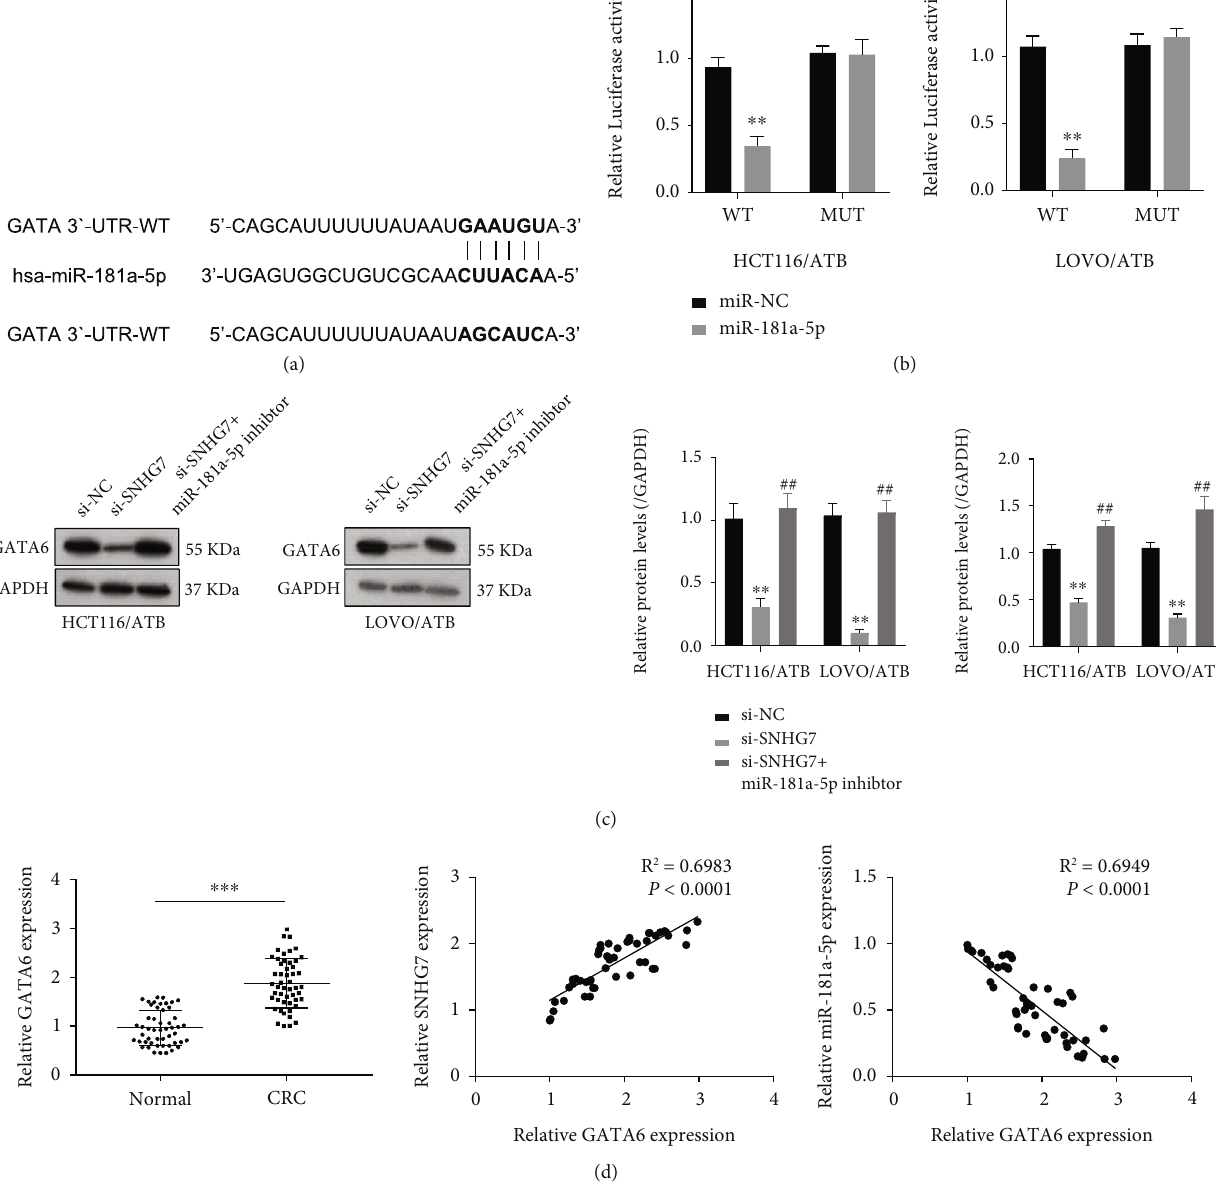
Figure 4: SNHG7 promotes GATA6 expression via sponging miR-181a-5p. (a) Potential binding site of miR-181a-5p in GATA6 found by TargetScan. (b) Luciferase reporter assay to verify the interaction between miR-181a-5p and GATA6 in HCT116/ATB and LOVO/ATB cell lines. miR-181a-5p overexpression inhibited Luciferase activity, but the inhibition disappeared when the binding site was mutated in GATA6. (c) Western blot and qRT-PCR showing the downregulation of GATA6 by SNHG7 knockdown and the upregulation of GATA6 by the transfection of miR-181a-5p in HCT116/ATB and LOVO/ATB cell lines. (d) qRT-PCR measurement to check the expression level of GATA6 in 50 pairs of CRCs and the adjacent tissues. A signi fi cant negative correlation between GATA6 and miR- 181a-5p and a signi fi cant positive correlation between GATA6 and SNHG7 were observed by Spearman correlation analysis in 50 cases of CRC. The statistical di ff erences were evaluated by Student ’ s t -test (* P < 0 : 05 , ** P < 0 : 01 , and *** P < 0 : 001